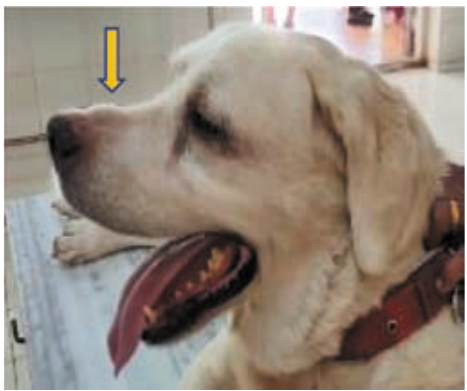
Fig. 1. A swelling behind the muzzle extending to the left of nasal